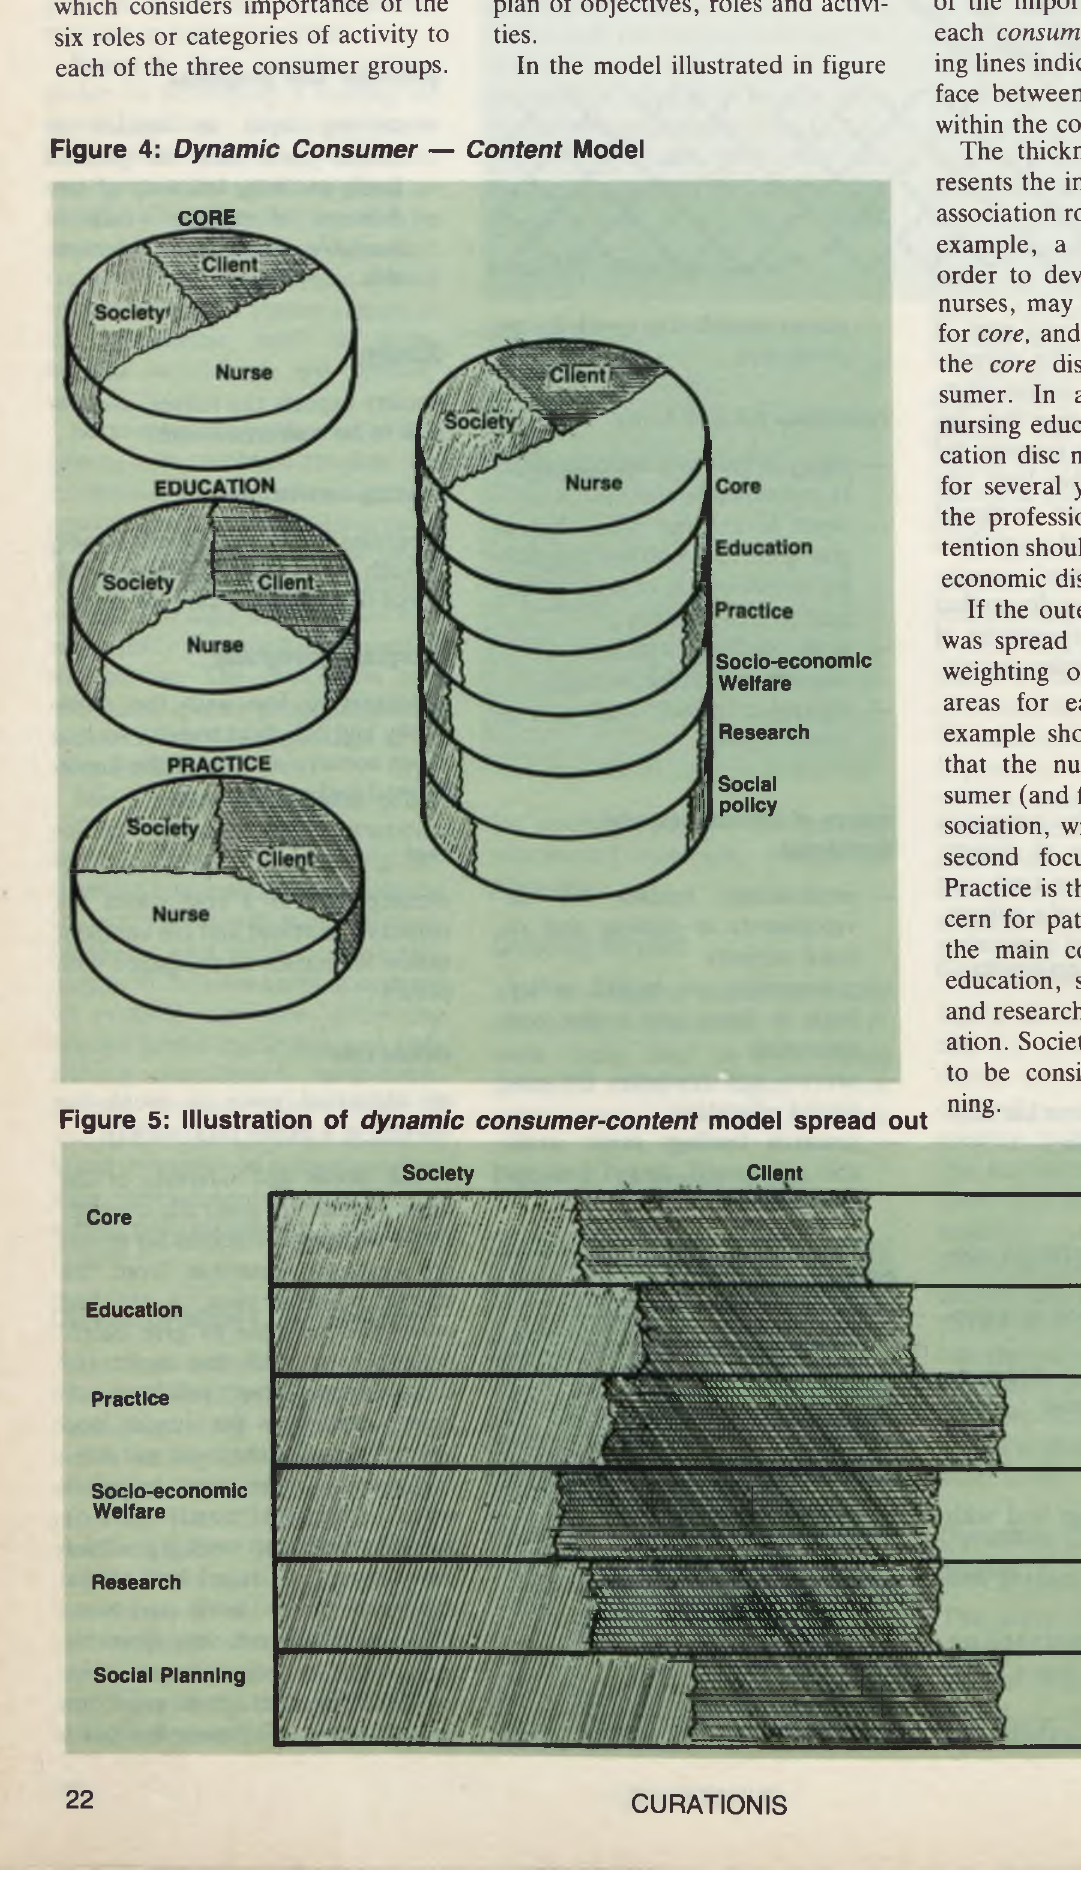
Figure 5: Illustration of dynamic consumer-content model spread